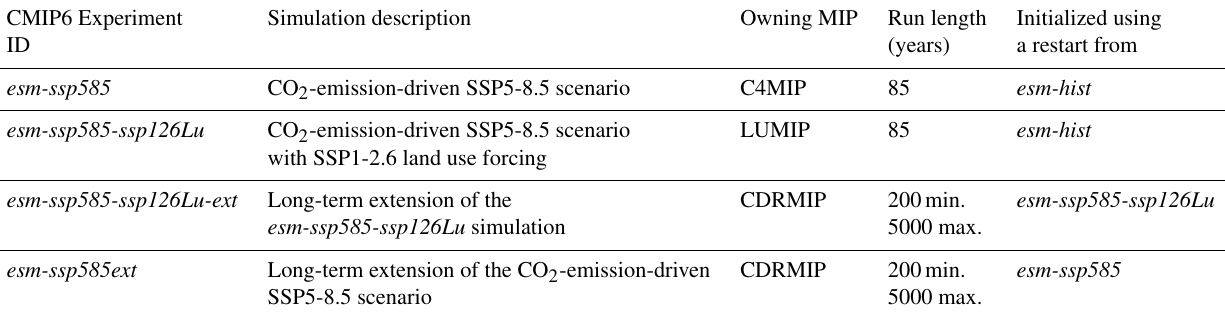
Table 6. Afforestation–reforestation experiment ( CDR-afforestation ) simulations. All simulations are required to complete the experiment. CMIP6